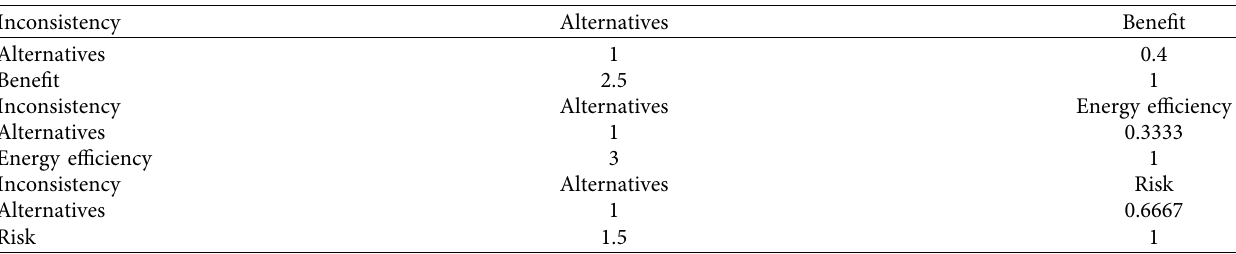
Table 3: Criteria layer and the alternative selection comparison value list of the rural land circulation mode performance evaluation.